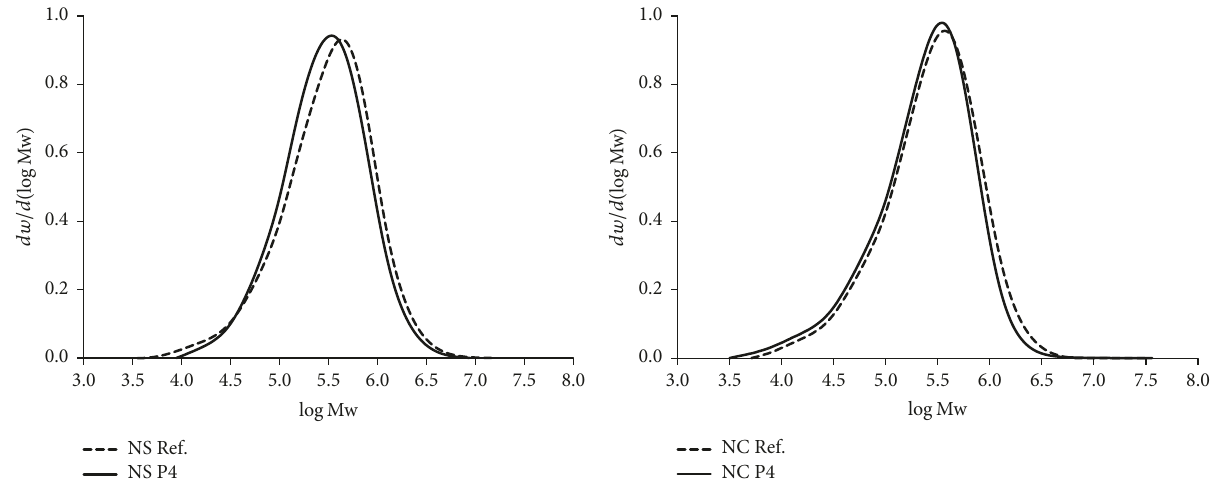
Figure 5: Distribution of the molar masses in PMMA nanoparticles reference (Ref.; drug free) and with 20mg NC: